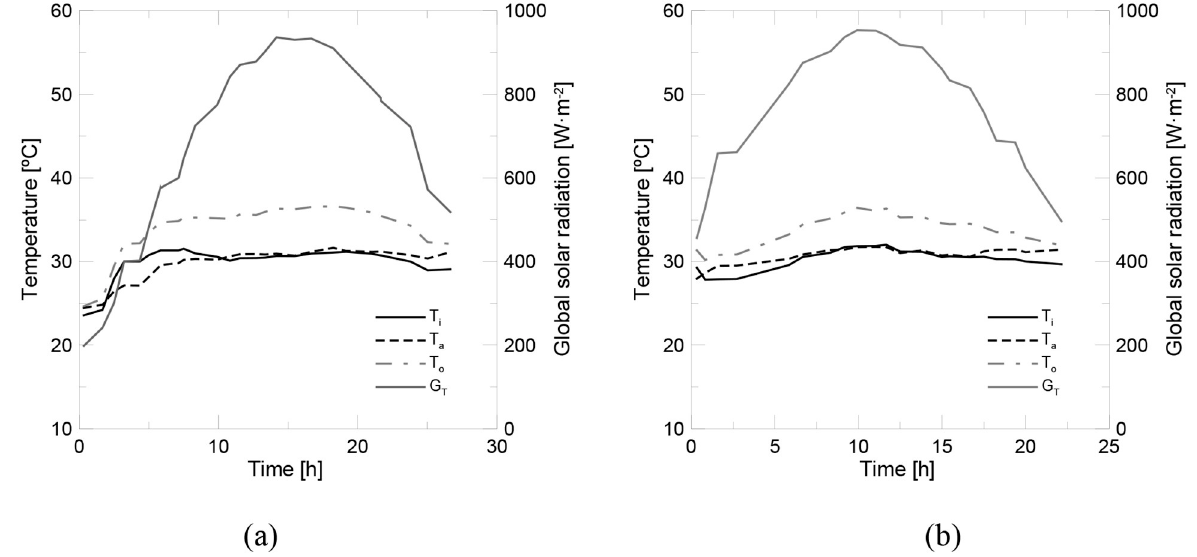
Fig 8. Experimental data for (a) water and (b) the alumina nanofluid at 1 v% (2.4